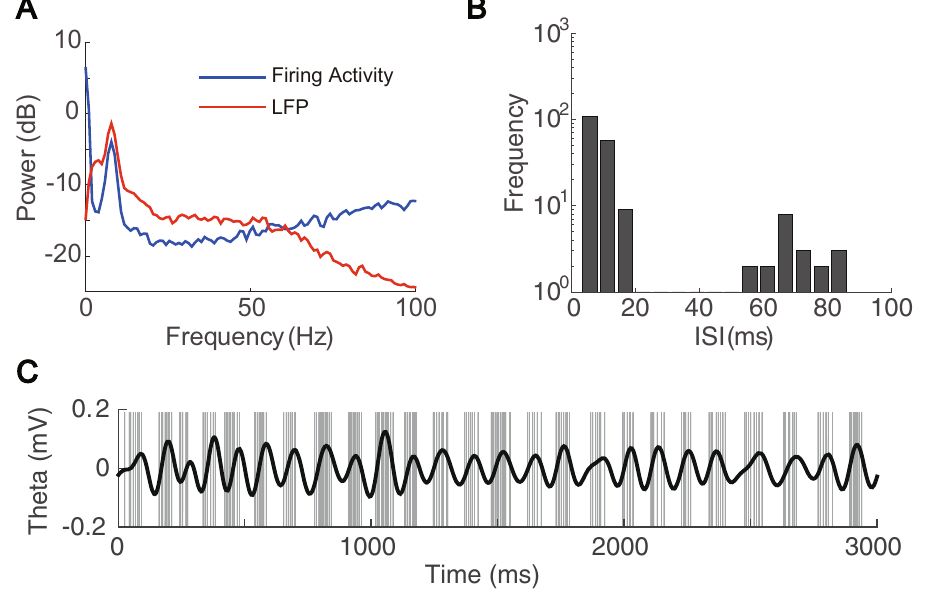
Figure 1. Properties of a theta-driving neuron. ( A ) Power spectra of a theta-driving neuron’s firing activity (blue) and the LFP signal (red). ( B ) The bimodal distribution of the ISI of the theta-driving neuron. ( C ) The time series of the theta-driving neuron’s firing activity and the corresponding theta wave. The time of each spike is indicated by a gray vertical line and the theta wave is plotted in black color. The theta-driving neuron tends to fire in the ascending phase of the theta